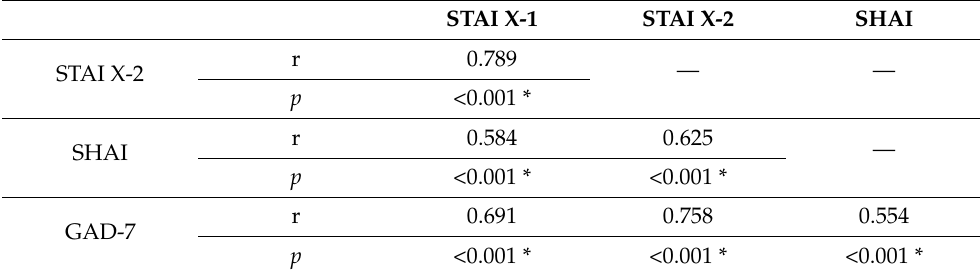
Table 7. Spearman’s rank correlations between standardised psychometric scales used in the